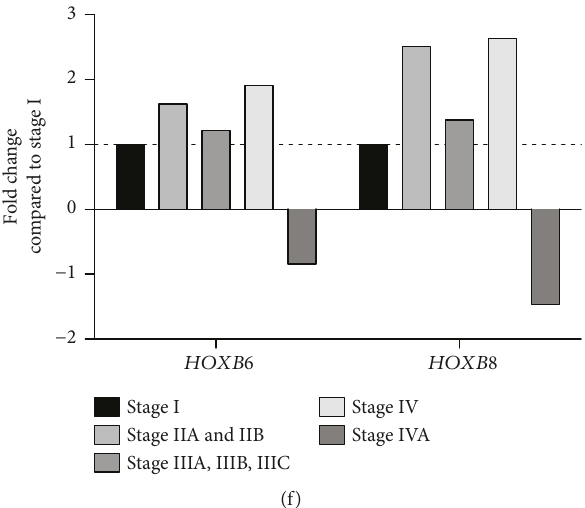
Figure 4: HOX gene expression during di ff erent stages of CRC. RNA sequencing data for CRC patients obtained from The Cancer Genome Atlas (TCGA) for HOX gene expression (normalized FPKM) and analyzed based on di ff erent stages of CRC. We studied (a) 55 cases for stage I, (b) 102 cases for stage IIA and IIB combined, (c) 66 cases reporting stage IIIA, IIIB, and IIIC, (d) 39 samples for stage IV, and (e) 4 cases for stage IVA. (f) Fold changes in the expression of HOXB6 and HOXB8 are shown for stages II, III, IV, and IVA compared to stage I.